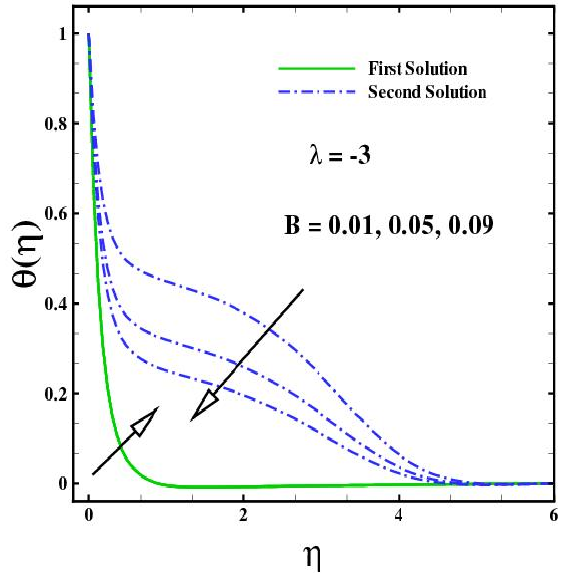
Figure 9. Influence of temperature with different values of B and M = 0.1, We = β = 0.3, S = 4, Ec = A = 0.01, and Pr = n = 2.